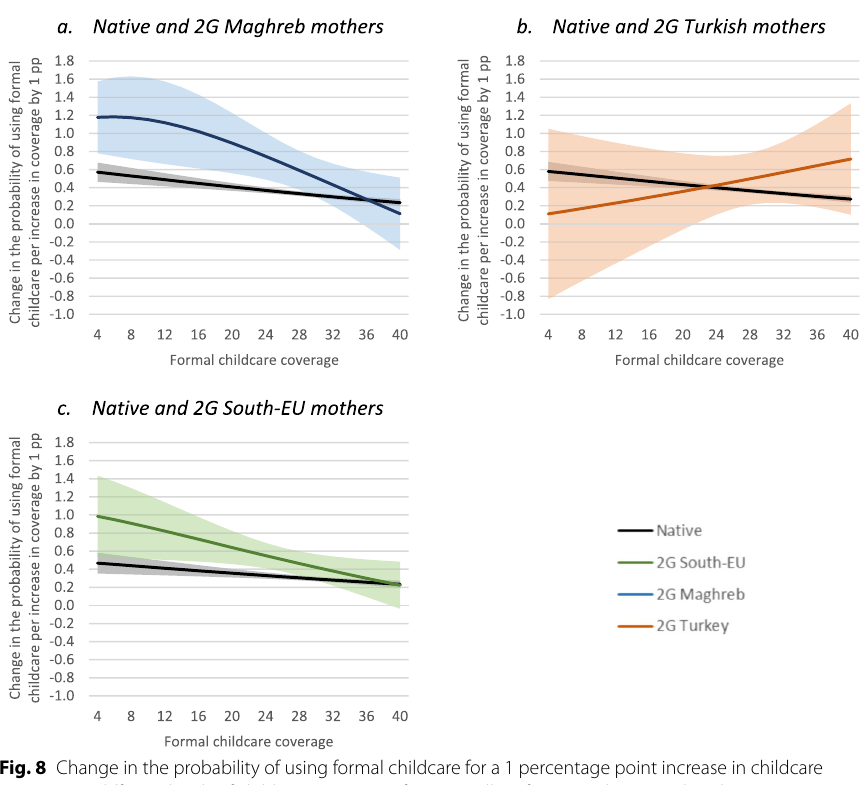
Fig. 8 Change in the probability of using formal childcare for a 1 percentage point increase in childcare coverage at different levels of childcare coverage after controlling for socio-demographic characteristics (with 95% conf. interval), by mother’s origin group. Average Marginal Effects based on Model 4 including municipality fixed effects, coverage (quadratic specification), origin, origin * municipality, origin * coverage (quadratic specification), mothers’ educational level, mother’s age at first childbirth, the age of the first child at the end of the year, and the fathers’ migration background. (Source: Belgian Census 2011 linked to longitudinal register data, longitudinal tax return data on childcare expenses and municipality-level data on childcare coverage from K&G and ONE. Calculations by